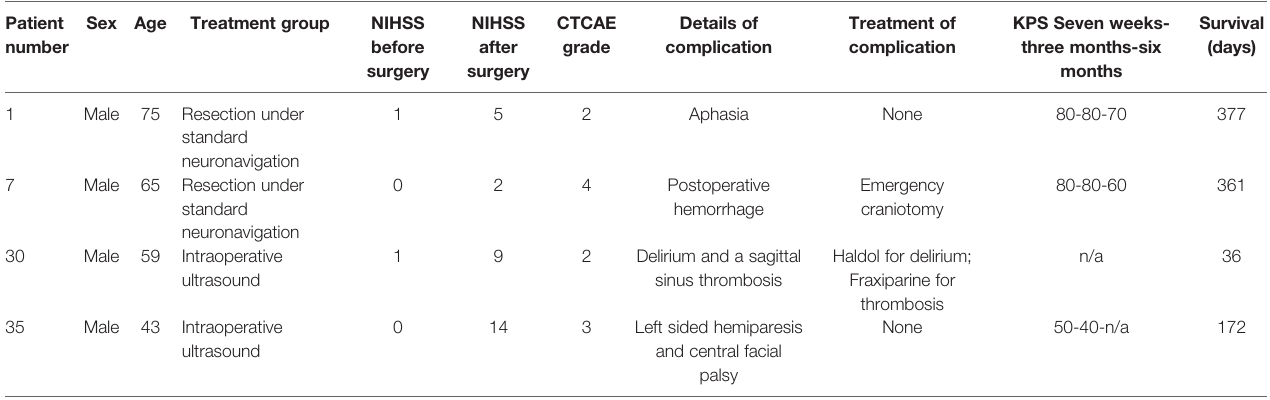
TABLE 4 | Details of patients with complications. Patient Sex Age Treatment number